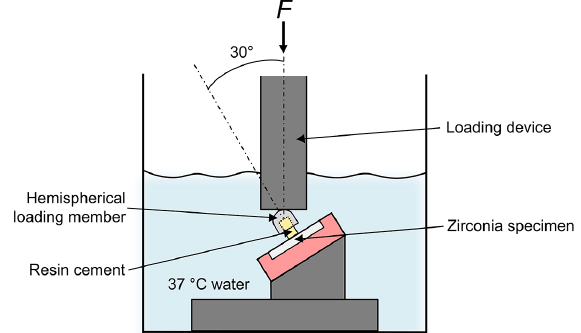
Figure 1. Illustration of mechanical load cycling simulator and specimen design. Loading device was allowed free movement transverse to loading direction.